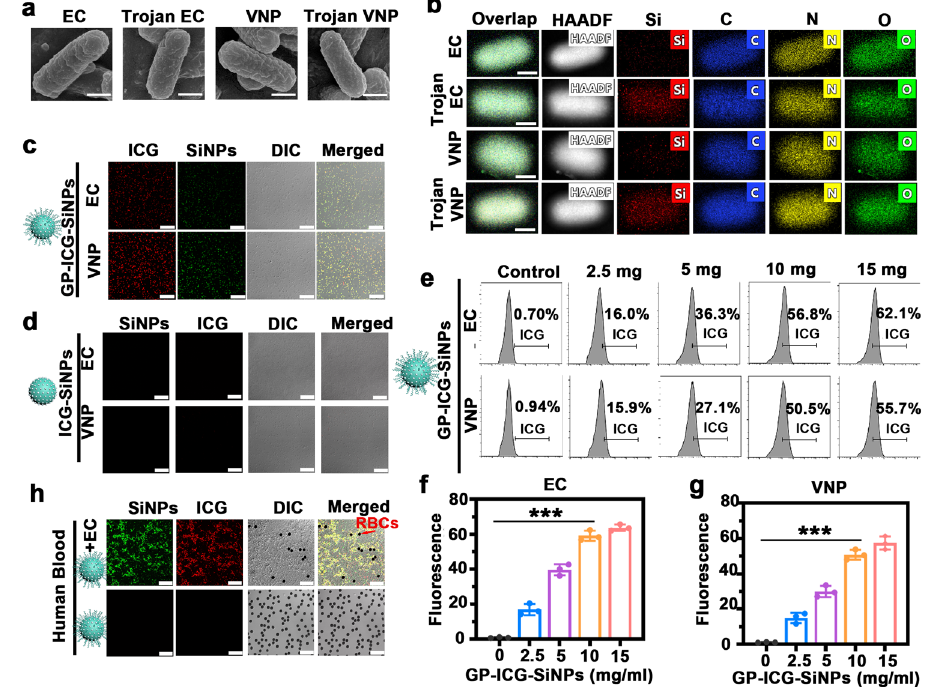
Fig. 2 | Construction and characterization of Trojan bacteria system. a SEM images of EC, Trojan EC, VNP, and Trojan VNP. Scale bars: 200nm. b Elemental mapping in HAADF-STEM images of EC, Trojan EC, VNP, and Trojan VNP. Scale bars: 500nm. c CLSM images of EC and VNP incubated with GP-ICG-SiNPs. Scale bars:25 μ m. d CLSMimagesofECandVNPincubatedwithICG-SiNPs.Scalebars: 25 μ m. All imaging experiments were repeated three times with similar results. e – g Flow cytometry analysis of the uptake rates of EC and VNP incubated with different concentrations of GP-ICG-SiNPs for 2h ( e ) and corresponding quan- titative analysis of uptake rates of different concentrations of GP-ICG-SiNPs by EC ( f ) and VNP ( g ). *** p =4.80×10 − 6 ( f ), *** p =7.46×10 − 6 ( g ). h CLSM images of